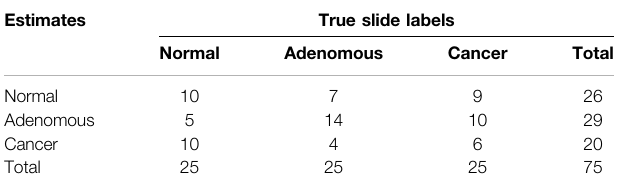
TABLE 3 | Confusion between slide classi fi cations and slide labels for grid